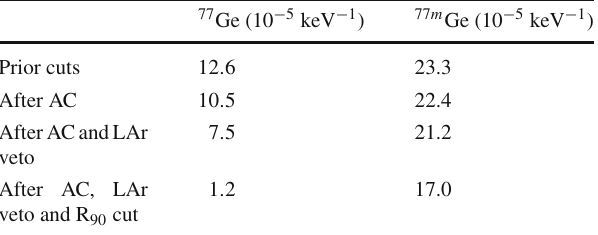
Table 1 Spectral contribution of 77 Ge and 77 m Ge decays at Q ββ ± 100 keV before and after applicationof detectoranti-coincidence (AC), liquid argon (LAr) veto and PSD multi-site rejection (R 90 )